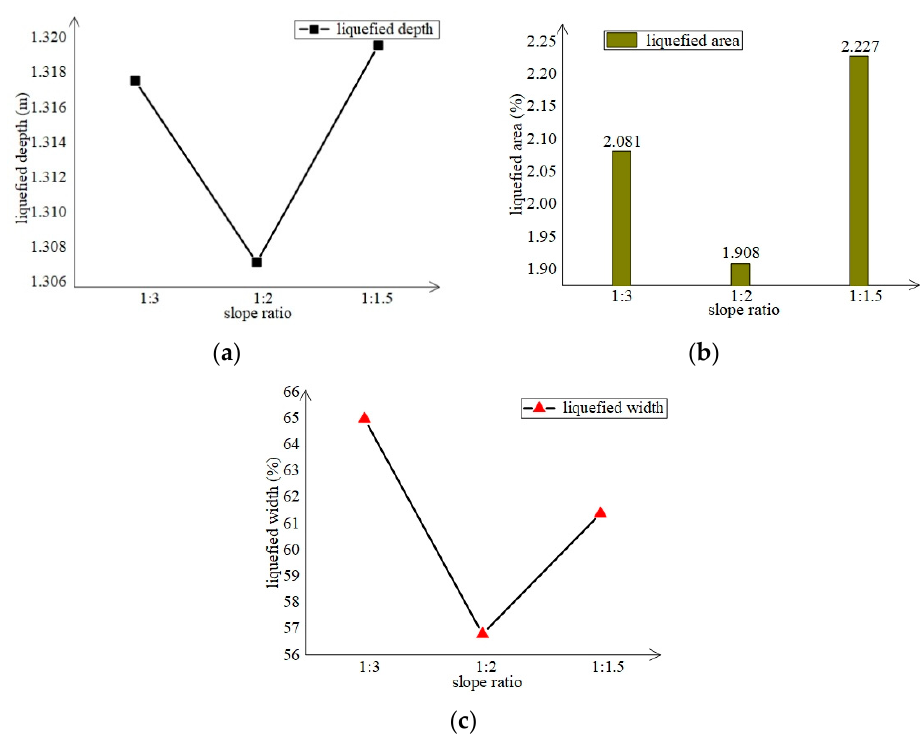
Figure 13. The liquefied conditions around the trench with different slope angles: ( a ) depth of liquefied seabed, ( b ) area of liquefied seabed, ( c ) width of liquefied seabed.